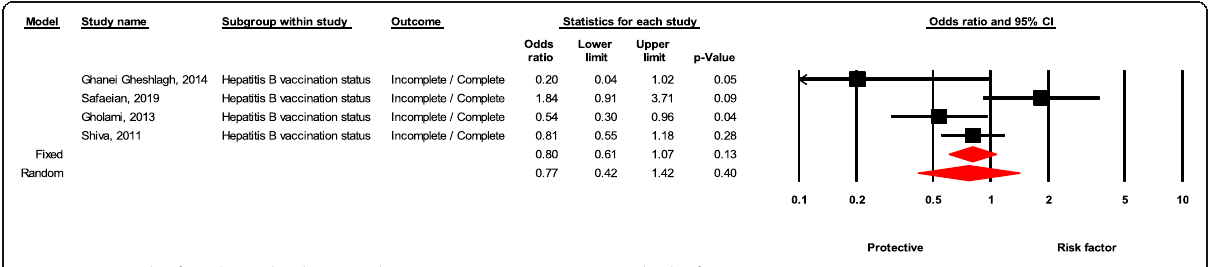
Fig. 10 Forest plot for relationship between hepatitis B vaccination status and risk of NSI in Iran